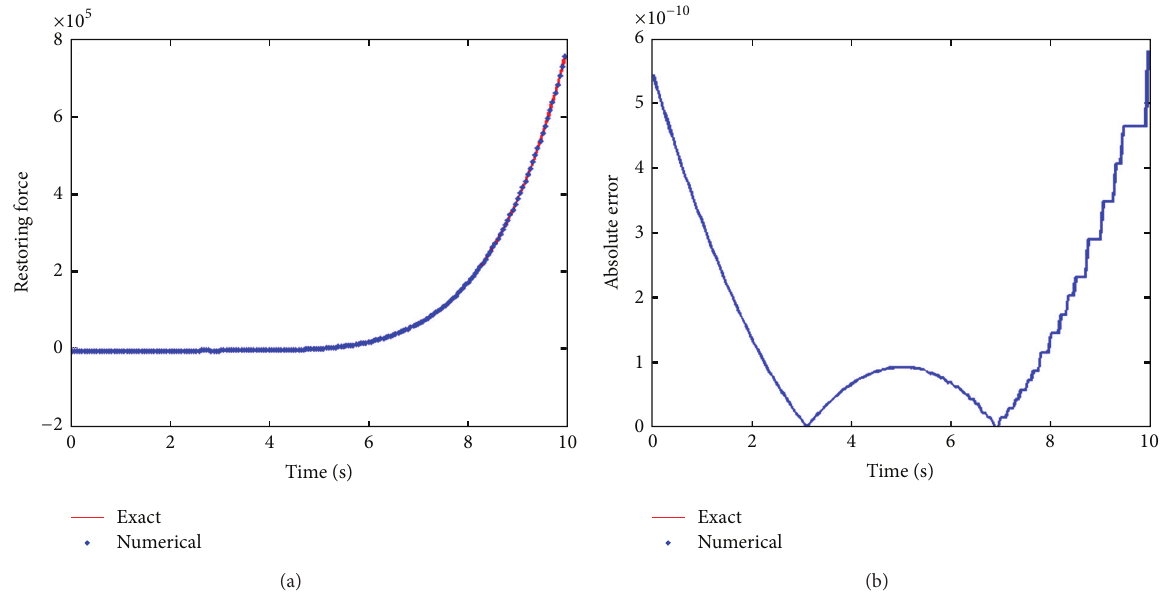
Figure 4: For Example 1, (a) comparing the exact solution and numerical one for restoring force and (b) displaying the estimated error of restoring